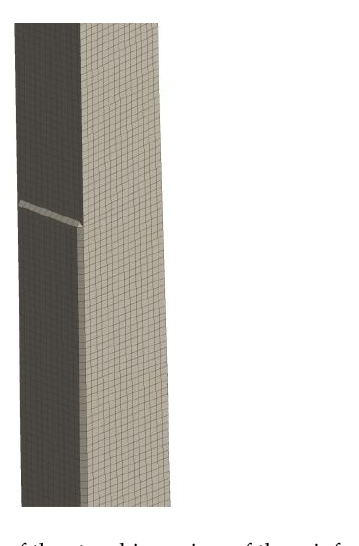
Figure 7. Finite element model of the stanchion: view of the reinforcement plate.